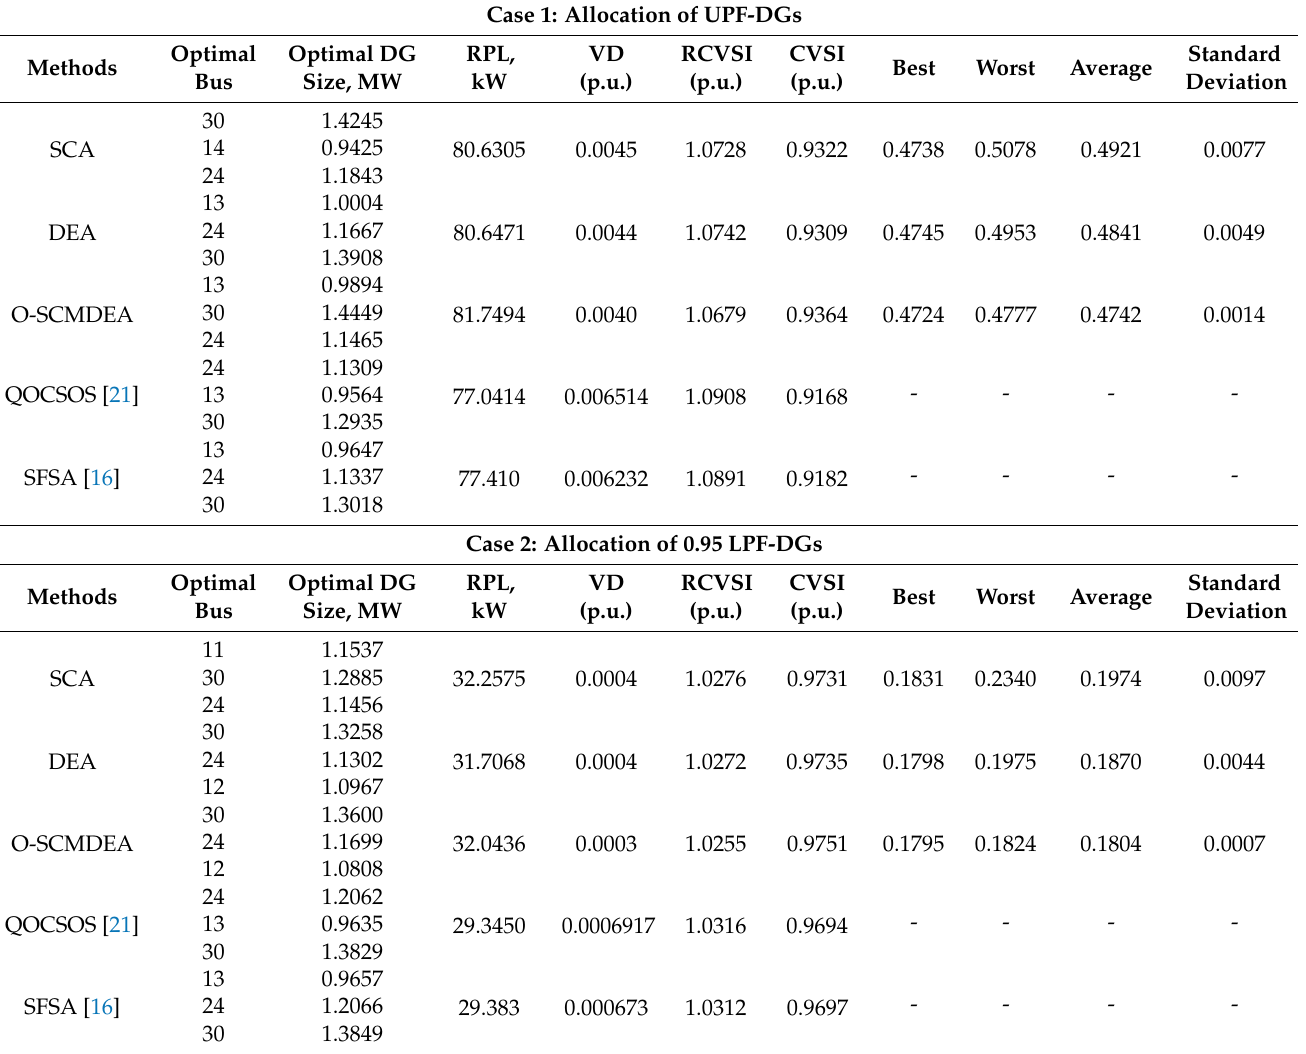
Table 7. Comparison of the results for the simultaneous optimization of the RPL, VD and RCVSI of 33 bus DN. Case 1: Allocation of